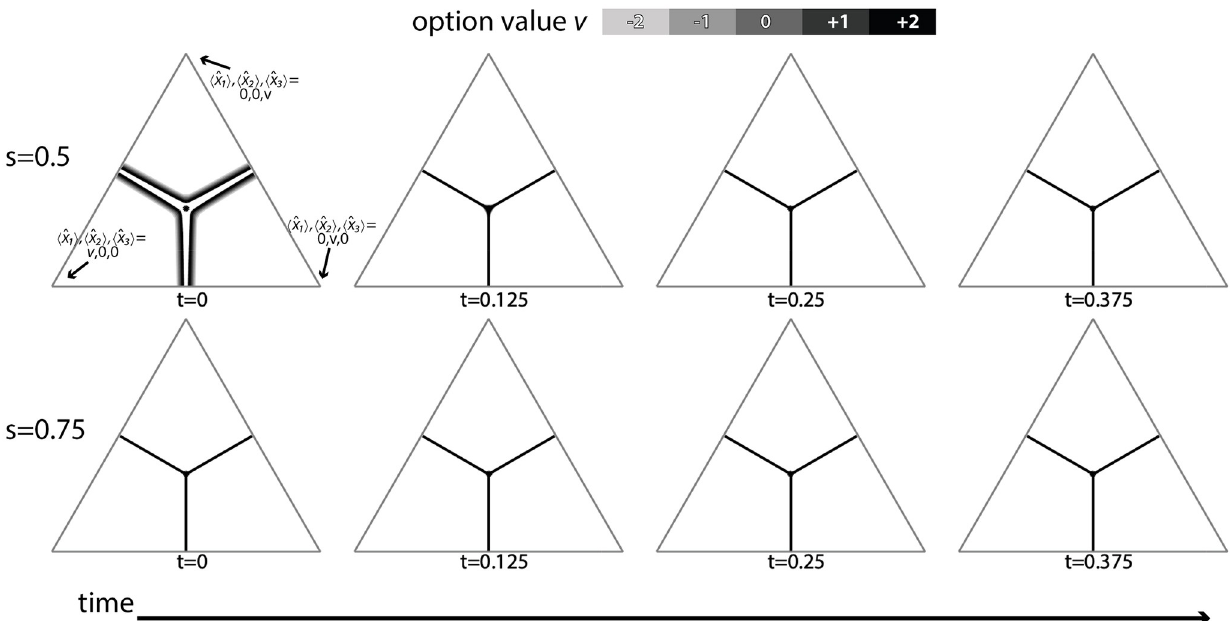
Fig 4. Optimal decision boundaries in the space of possible estimates of option values: Optimal policies for linear time cost (Bayes Risk) rapidly transition from approximately linear subjective utility, and hence weakly magnitude-sensitive, decision boundaries in estimate space (Fig 3, top row for s = 0.25; present figure, top row for s = 0.5, to more step-like subjective utility where immediate ‘choose the best’ decision-boundaries are necessarily magnitude-insensitive (bottom row for s = 0.75, and higher values of s ). Triangles are low dimensional projections of the 3-dimensional evidence estimate space onto a plane moving along the equal value line, at value v [4]. Dynamic programming parameters were: prior mean � x ¼ 5 , and utility function parameters m = 4, s 2 {0.5, 0.75}. Time steps chosen to illustrate boundary collapse. variance s 2 p ; i